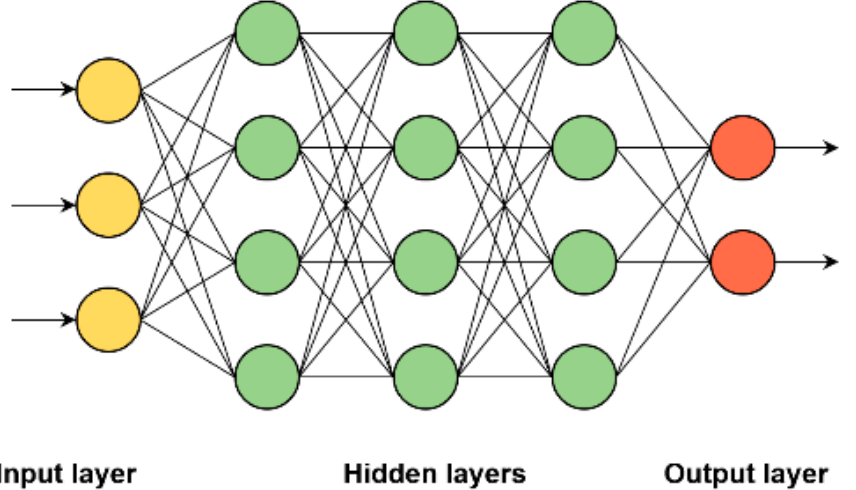
Figure 3. Architecture of Deep Learning Neural Network.